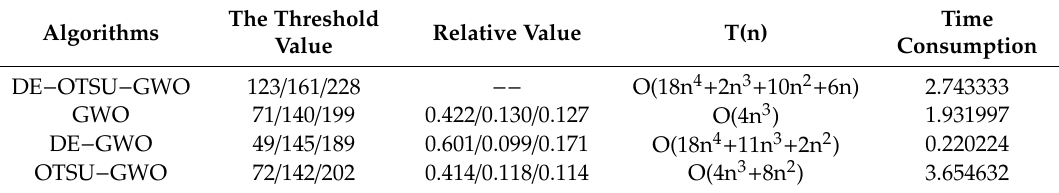
Table 8. Results of DE − OTSU − GWO algorithm analysis.